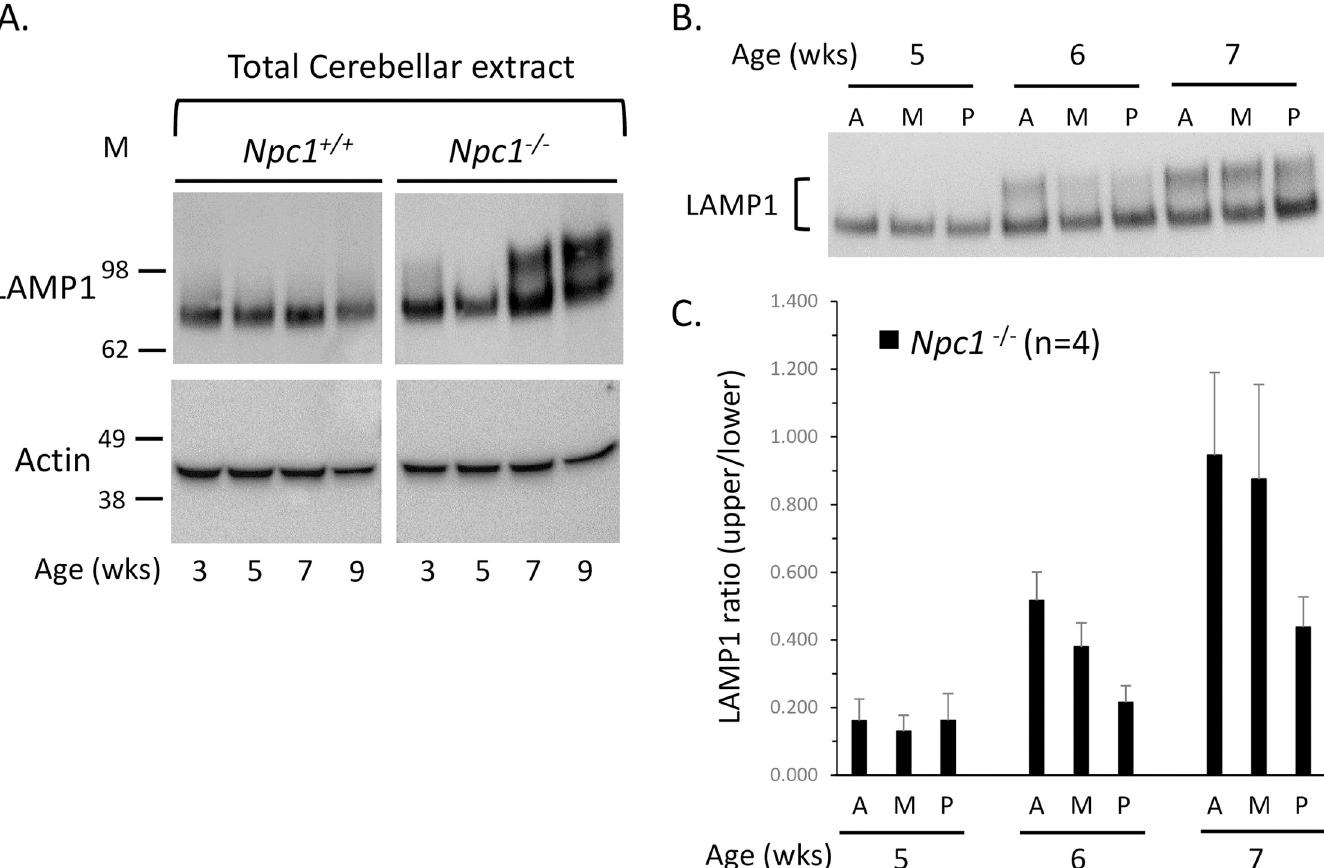
Fig 2. Spatiotemporal expression pattern of LAMP1. A. Western blot of total cerebellar extract from Npc1 +/+ and Npc1 −/− mice at 3, 5, 7, and 9 weeks of age, for LAMP1 and actin (loading control). B. Western blot of anterior (A), middle (M), and posterior (P) regions of cerebellum from Npc1 −/− mice at 5, 6, and 7 weeks of age, for LAMP1. C. The Western blot in (B) was replicated with different mice (n = 4) and the LAMP1 ratio (intensity of the higher molecular weight band to the lower molecular weight band) was calculated. The means of LAMP1 ratios were graphed. Two-way ANOVA indicates a significant difference (P < 0.001) in LAMP1 ratio across age, but only a trend across cerebellar region (P = 0.055). There is no significant interaction between age and cerebellar region (P >